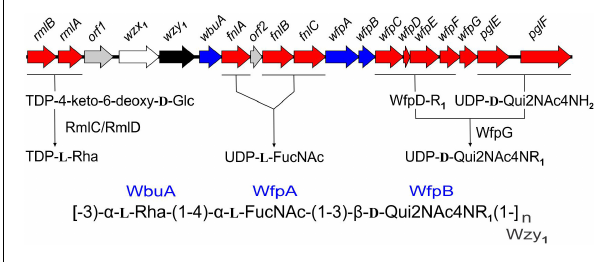
FIGURE 4 | Proposed genetic basis of Fp 950106-1/1 O-PS structure showing genes for nucleotide sugar biosynthesis (red), glycosyl transferases (blue), polymerase (black), flippase (white), and genes of unknown function (gray), which are given orf